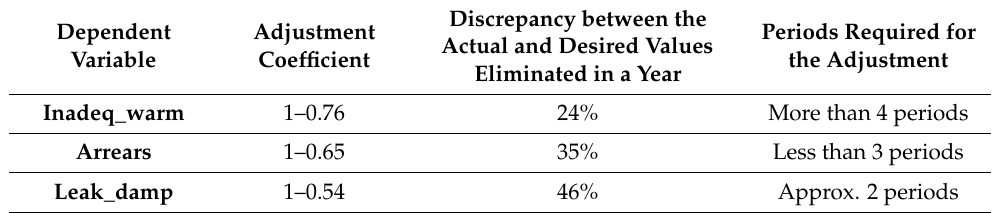
Table 7. Adjustment to equilibrium values, based on the lag in the dynamic models.